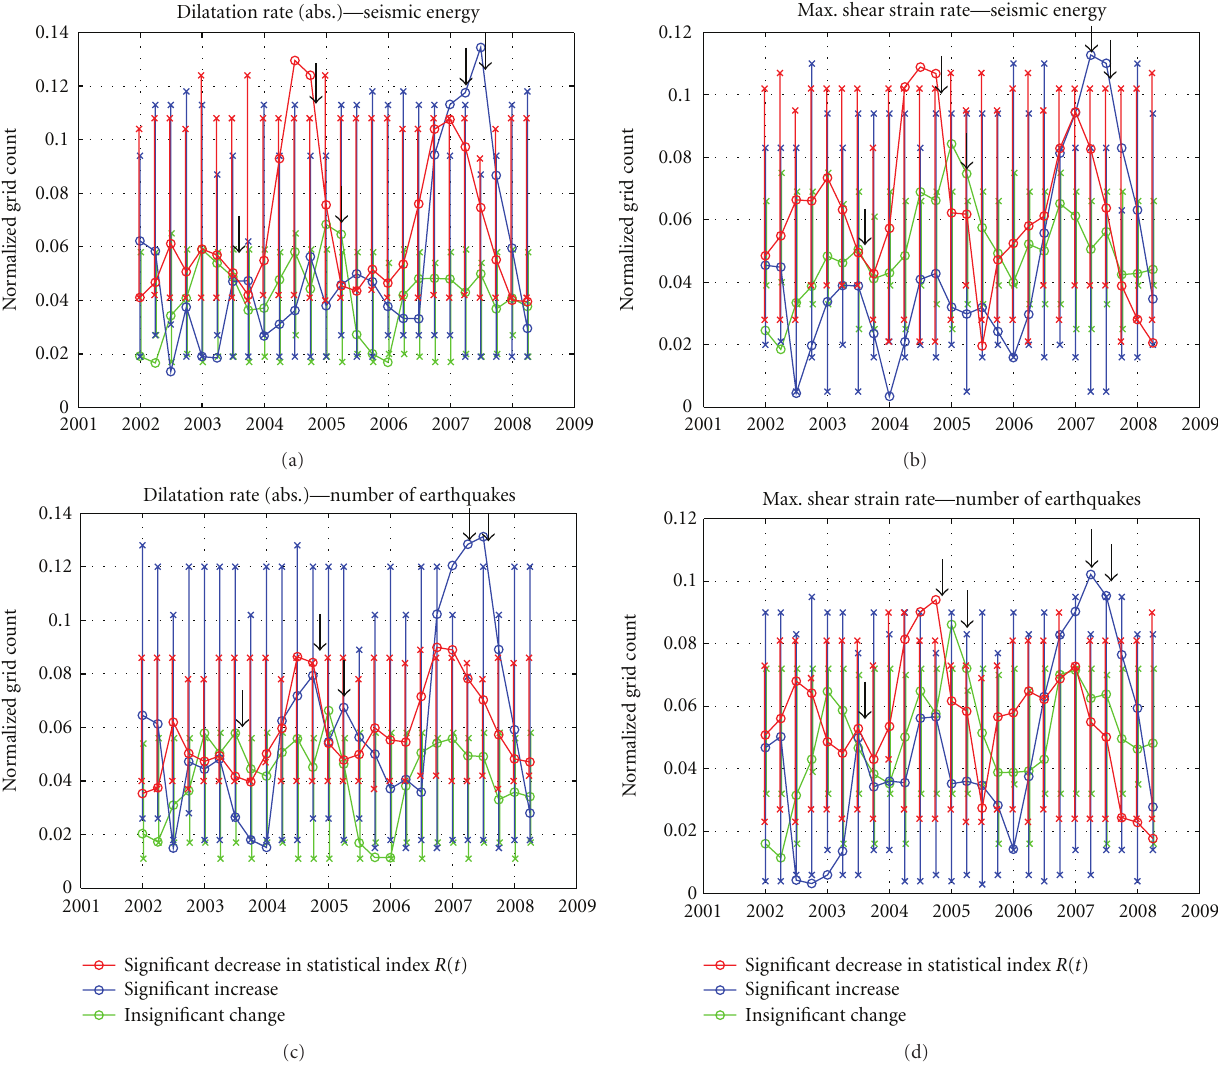
Figure 4: Temporal variation in no. PTN1, no. PTN2, and no. PTN3 (ref. Figure 3). Black arrows correspond to the occurrence date of M ≥ 6.0 inland mainshocks. Also shown are the error bars which were obtained by 100 times of shu ffl ing of no. PTN1, no. PTN2, and no. PTN3 in time, respectively. The horizontal axis denotes the time corresponding to the end of the time period referred to for calculation of linear trend of R ( t ). The beginning of each time period is fixed to April 1, 1998. Panels (a) to (d) correspond to di ff erent four pairs of geodetic and seismic quantities, which are the same as those in Figure